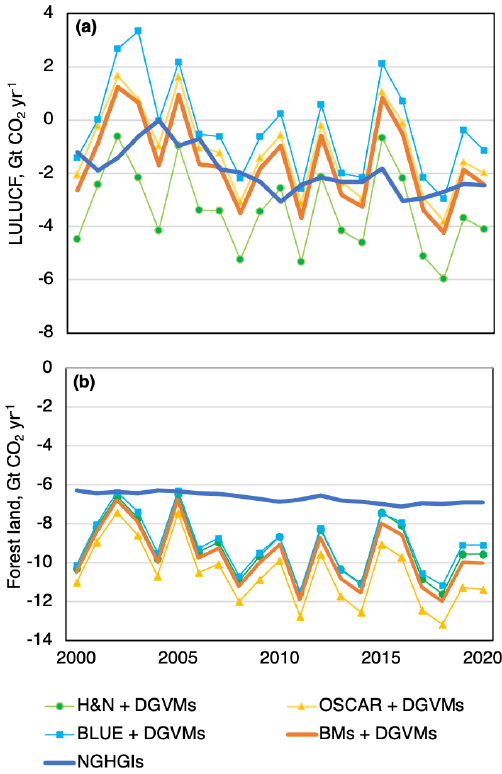
Figure 6. Adjusted CO 2 fluxes from BMs for LULUCF (panel a ) and for forest land (b) , i.e. original BMs’ results plus the natural sink from DGVMs in non-intact forest, compared to the NGHGIs for the period 2000–2020.